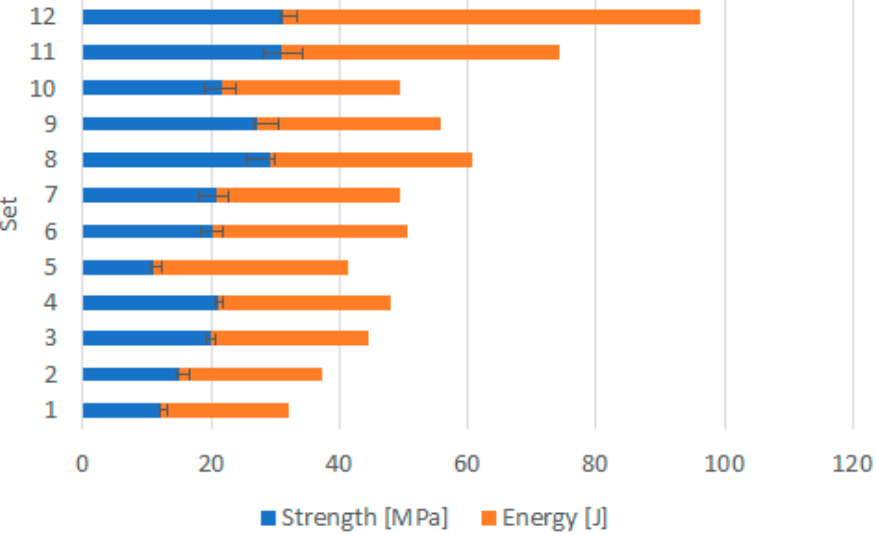
Figure 10. Relationship between energy and strength for each set of welding parameters—error bars indicate the minimum and maximum strength values reached in the tensile tests.